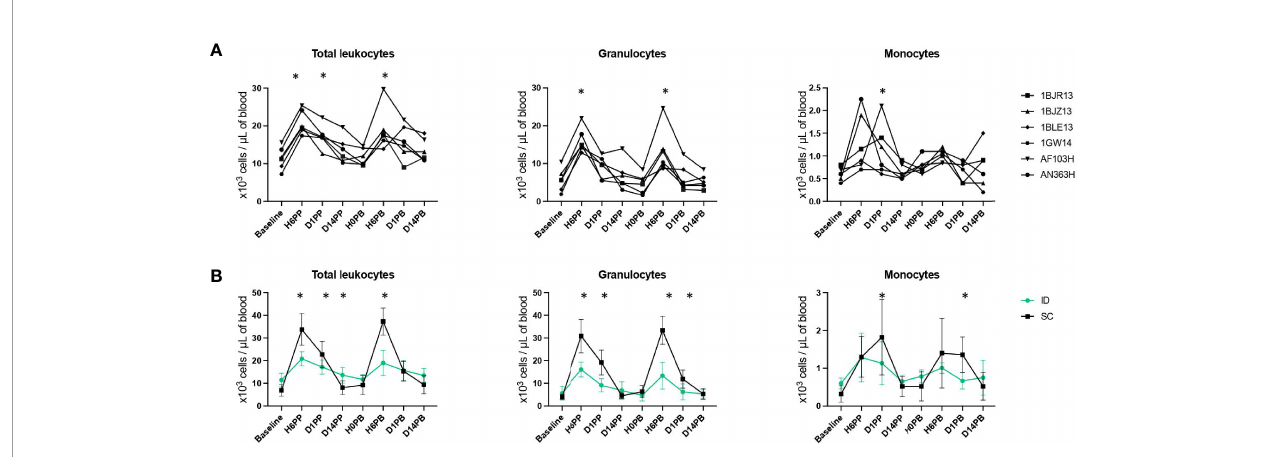
FIGURE 2 | Leukocyte counts in blood after ID or SC immunizations. (A) Longitudinal monitoring of total leukocyte, granulocyte (including neutrophils, eosinophils and basophils), and monocyte counts (in thousands per µl of blood) before and after ID immunizations for each animal. Immunizations are indicated by the blue dotted lines. Counts were compared to baseline using Wilcoxon tests. p-values < 0.05 were considered statistically signi fi cant and are indicated by an asterisk (*). (B) Comparison of leukocyte counts (in thousands per µl of blood) before and after immunization by the ID (in green) or SC (in black) route. Immunizations are indicated by the blue dotted lines. Counts were compared between routes of vaccine delivery using unpaired two-tailed t tests. Statistically signi fi cant p values (p < 0.05) are indicated by an asterisk